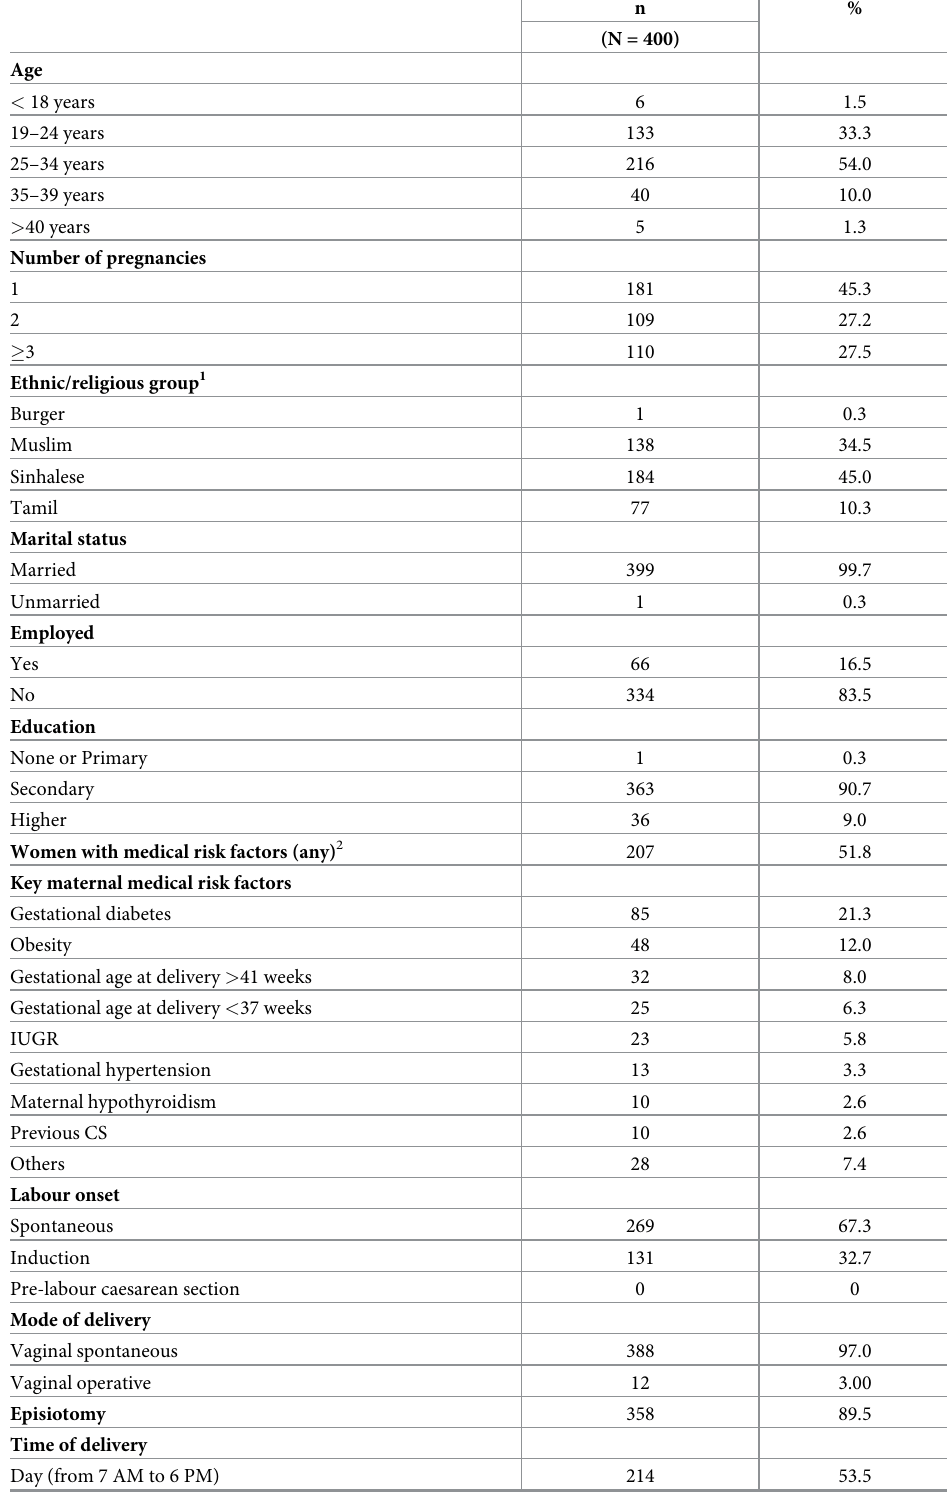
Table 1. Women’s